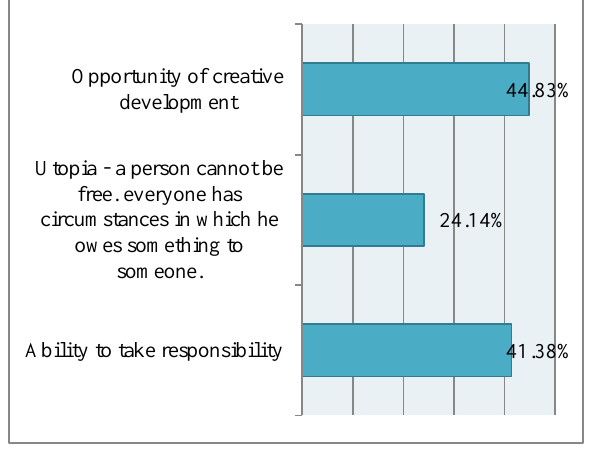
Fig. 7. The respondents' perceptions of freedom.